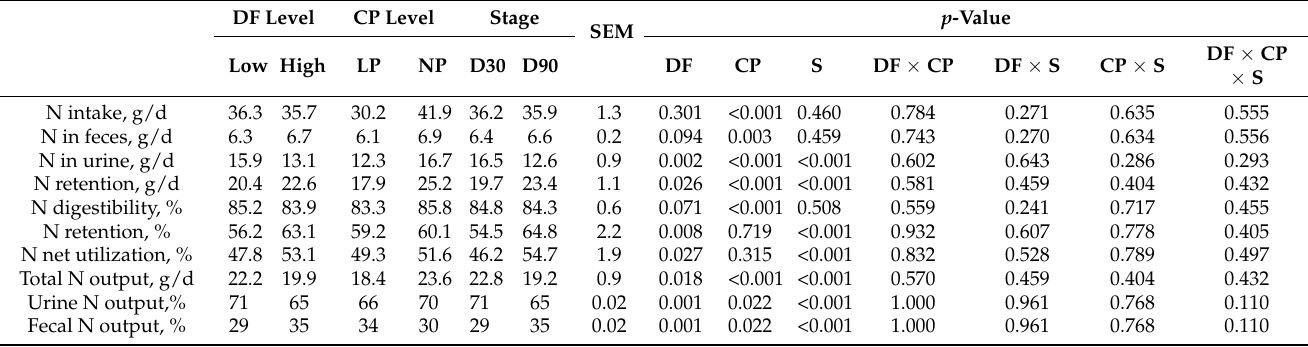
Table 3. Effects of dietary fiber and crude protein levels on nitrogen balance of gestating sows at different gestational